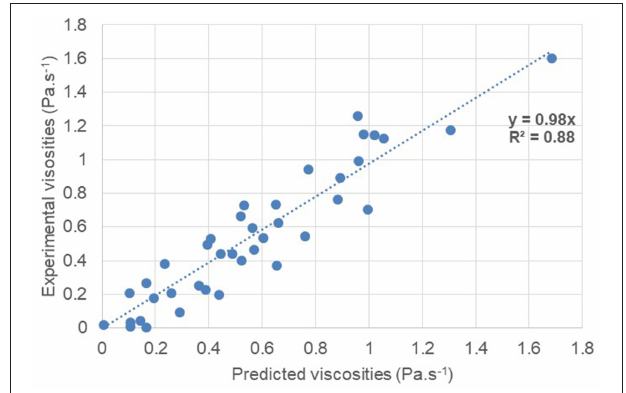
FIGURE 8 | Prediction accuracy of UP viscosity in solution according to the trained Neural Network.